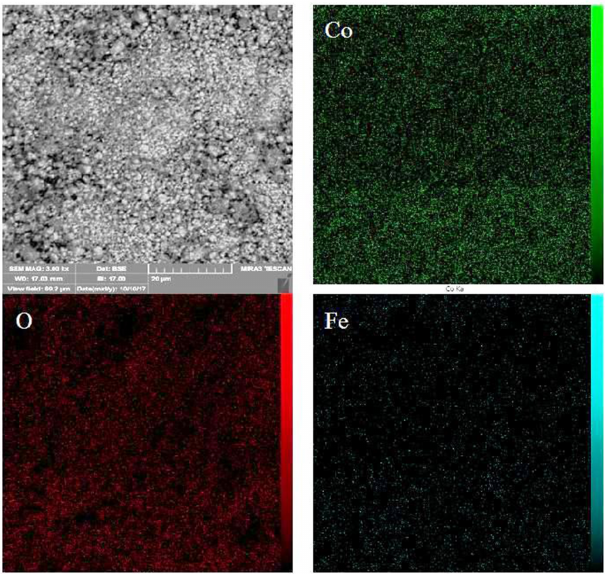
Fig. 4. X-ray map analyses of Co 3 O 4 -15 wt% Fe 2 O 3 sample after redox.